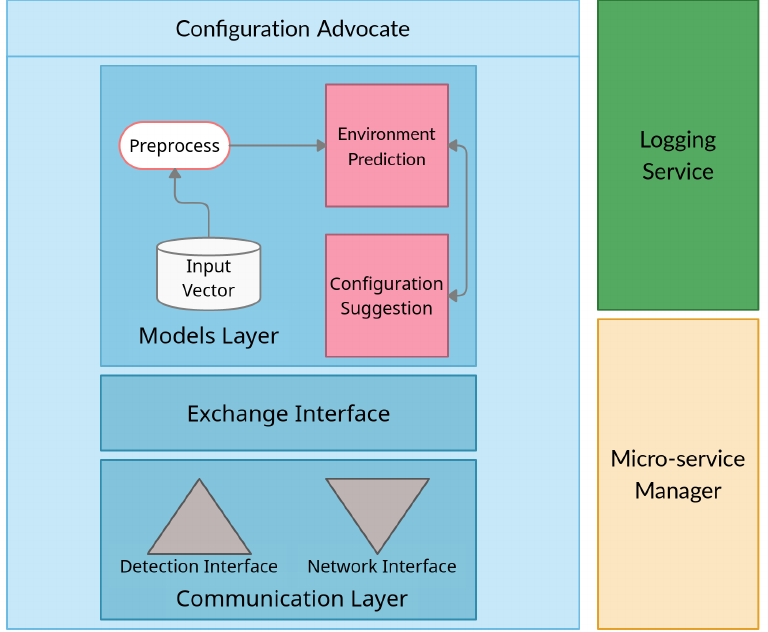
Figure 2. Proposed micro-services architecture which resides in the edge-cloud